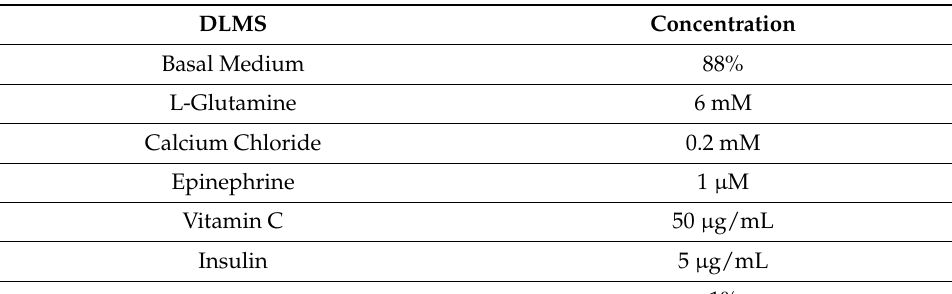
Table 1. Formulation of the melanocyte culture